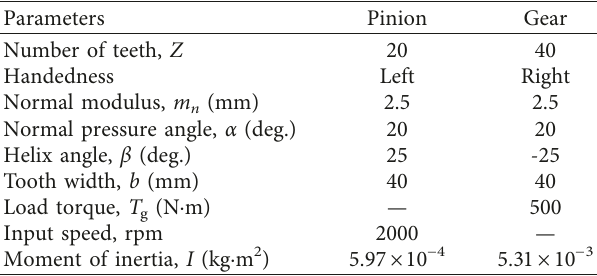
Table 2: Parameters of simple example. Parameters Pinion Gear Number of teeth, Z Left